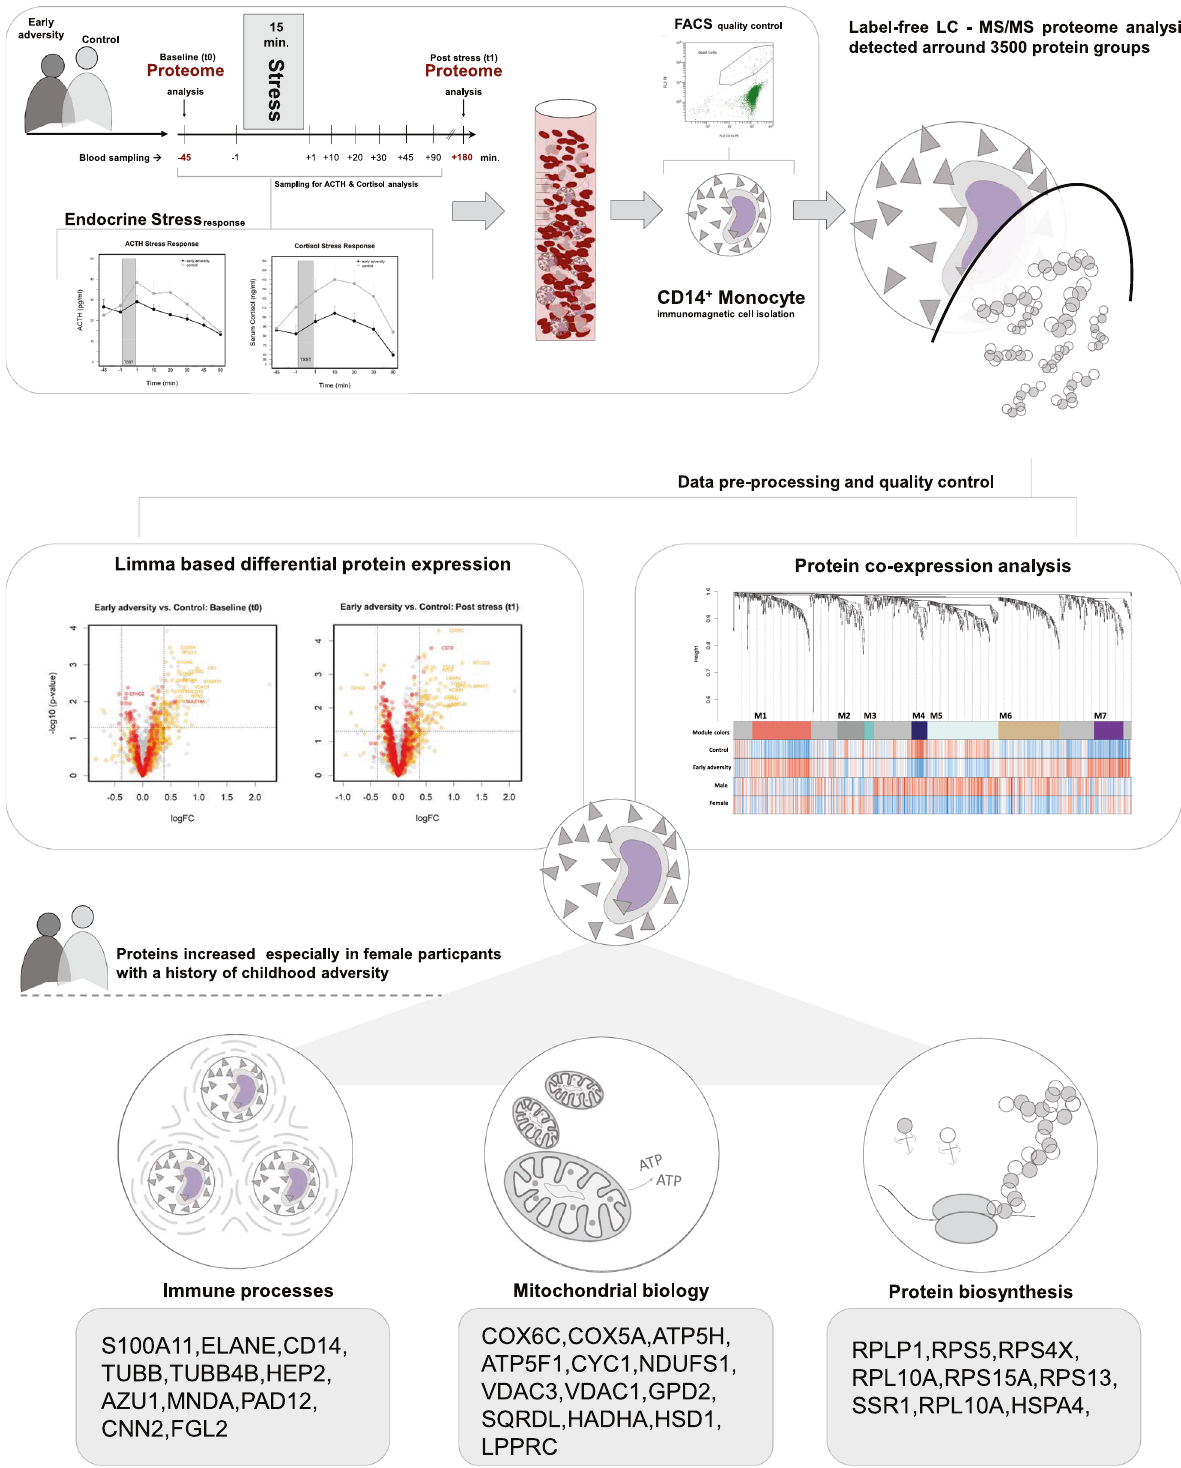
Fig. 1 Study design and central results. Healthy adults with a history of childhood adversity and a matched control group were exposed to a 15 min. standardized laboratory stress protocol (Trier Social Stress Test: TSST). Levels of the stress hormones cortisol and ACTH were determined from plasma taken before and after stress exposure (see SI for details). CD14 + monocytes were isolated from blood samples 45 min before (t0 baseline measurement) and 180 min following stress (t1 post-stress measurement). Unlabeled LC-MS/MS analysis, followed by differential expression analysis and protein co-expression analysis, was performed to assess differences in protein expression before and after stress, and between groups. We observed higher abundances of proteins involved in the immune system-relevant processes, protein metabolic processes, and mitochondrial biology, especially in females with a history of childhood